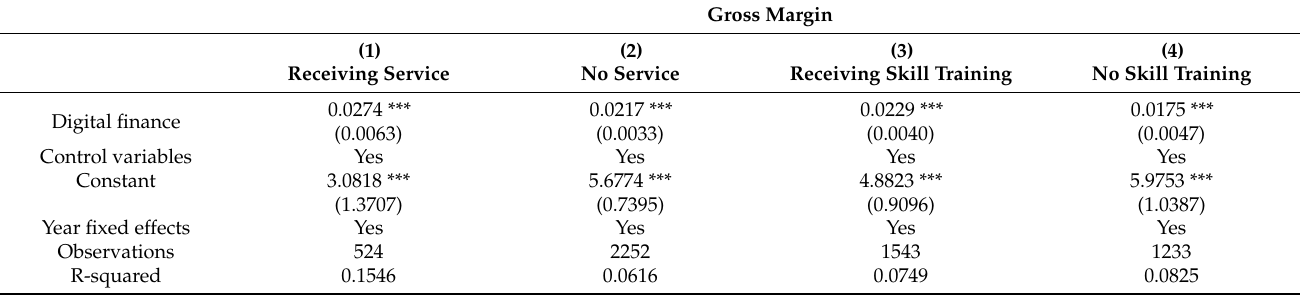
Table 8. Estimated results of different categories according to whether receiving agricultural service or